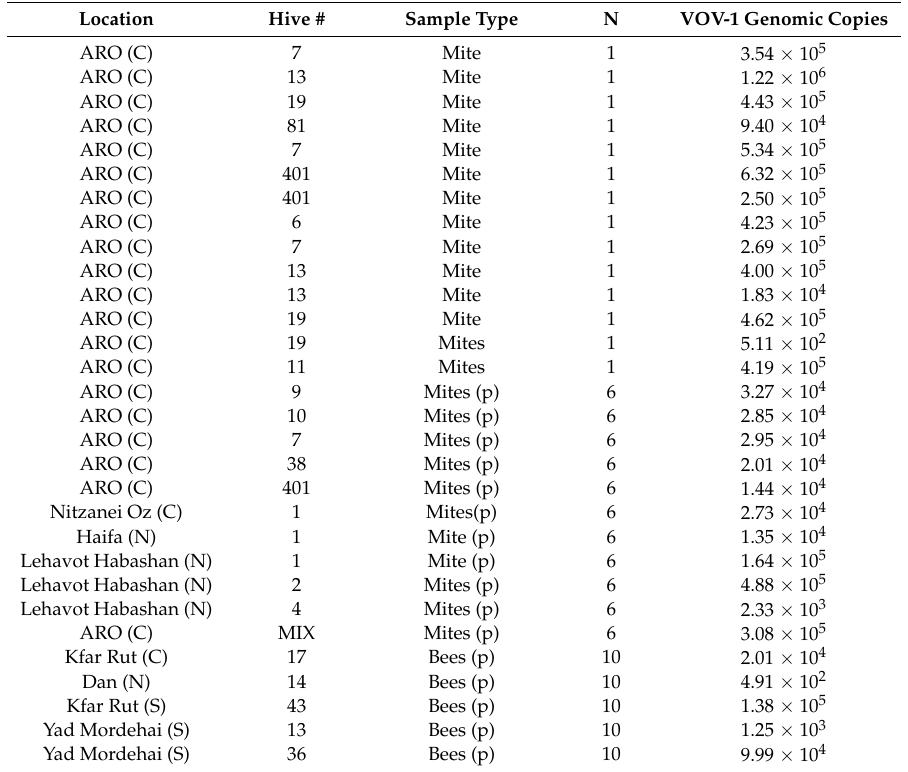
Table 5. Genomic copies of VOV-1 in individual mites and in pools of mites and nurse honeybees.